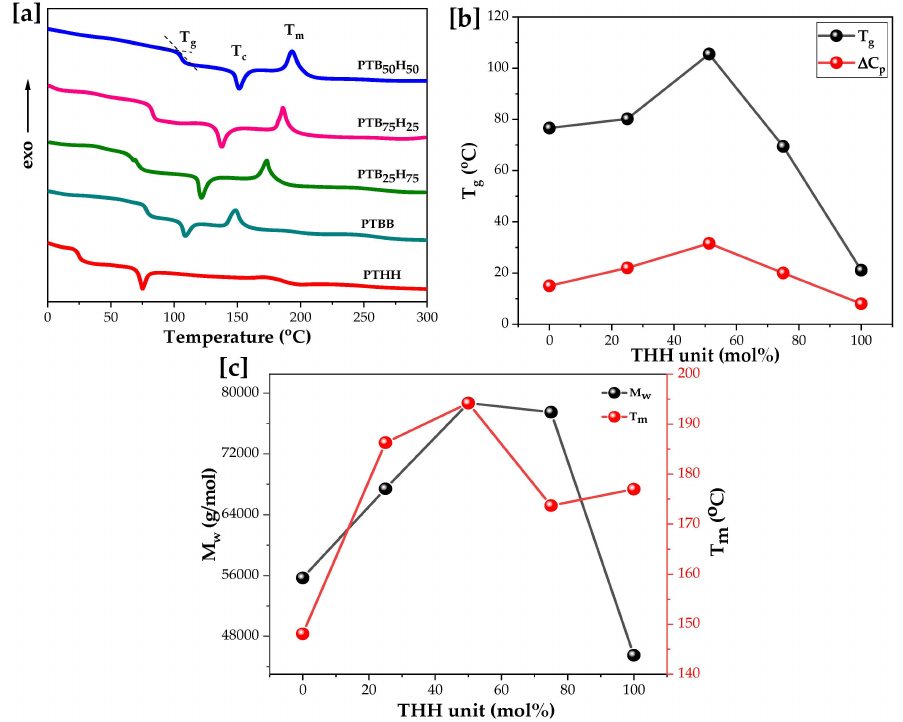
Figure 5. [ a ] DSC of poly(1,4-bis(2-hydroxyethyl)benzene thiophenedicarboxylate) (PTBB), poly(hexylene thiophenedicarboxylate) (PTHH), and poly(hexylene 2,5-thiophenedicarboxylate- co-bis(2-hydroxyethoxybenzene) (PTBxHy) copolyesters; [ b ] T g and ∆ Cp vs. mol% of THH unit; and [ c ] M w and T m vs. mol% of hexylene thiophenedicarboxylate (THH)